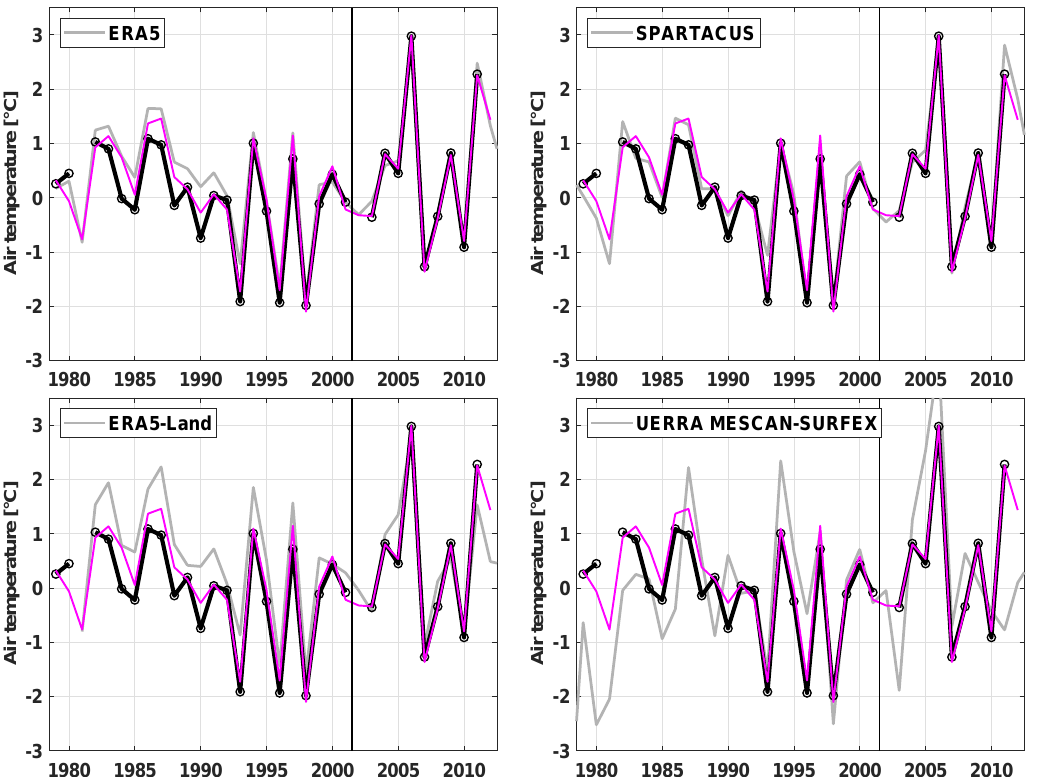
Figure 7. VERNAGT autumn (SON) air temperatures: observations (black), sDoG (magenta), and the reference data sets ERA5, SPARTACUS, ERA5-Land, and UERRA MESCAN-SURFEX (in grey). Note that for this figure the summer time series of the reference data sets are standardized to obs-training, because the emphasis is on season-to-season co-variability here (see Section 2.3). The performance in simulating the seasonal cycle is then illustrated separately in Figures 9 and